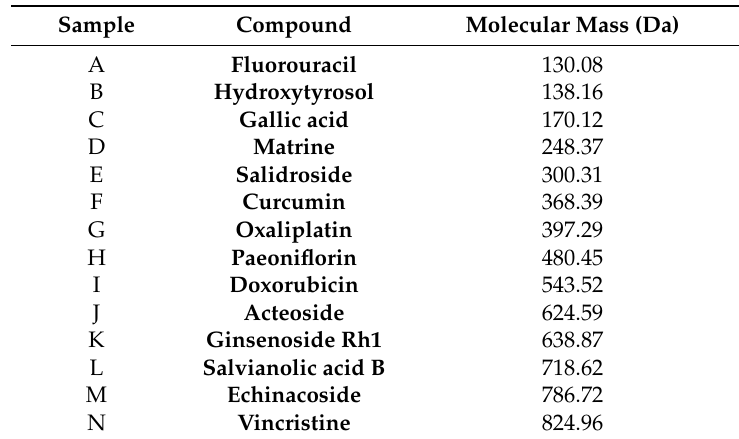
Table 1. Compounds used in